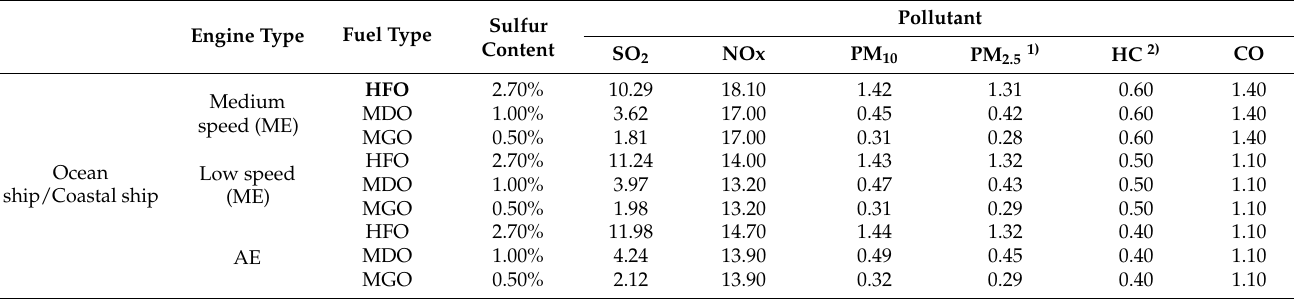
Table A2. Value of ship emission factor